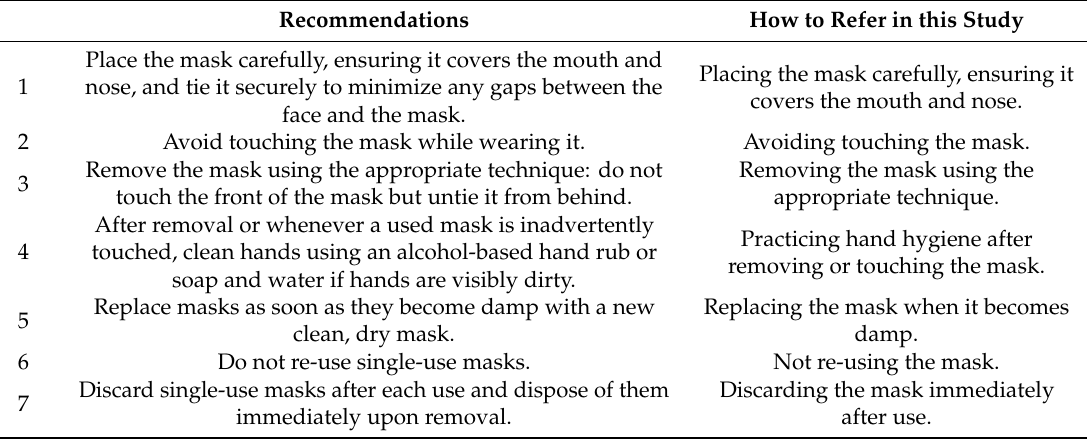
Table 1. Recommendations on the correct use of face masks according to the interim guidance issued by the World Health Organization 1